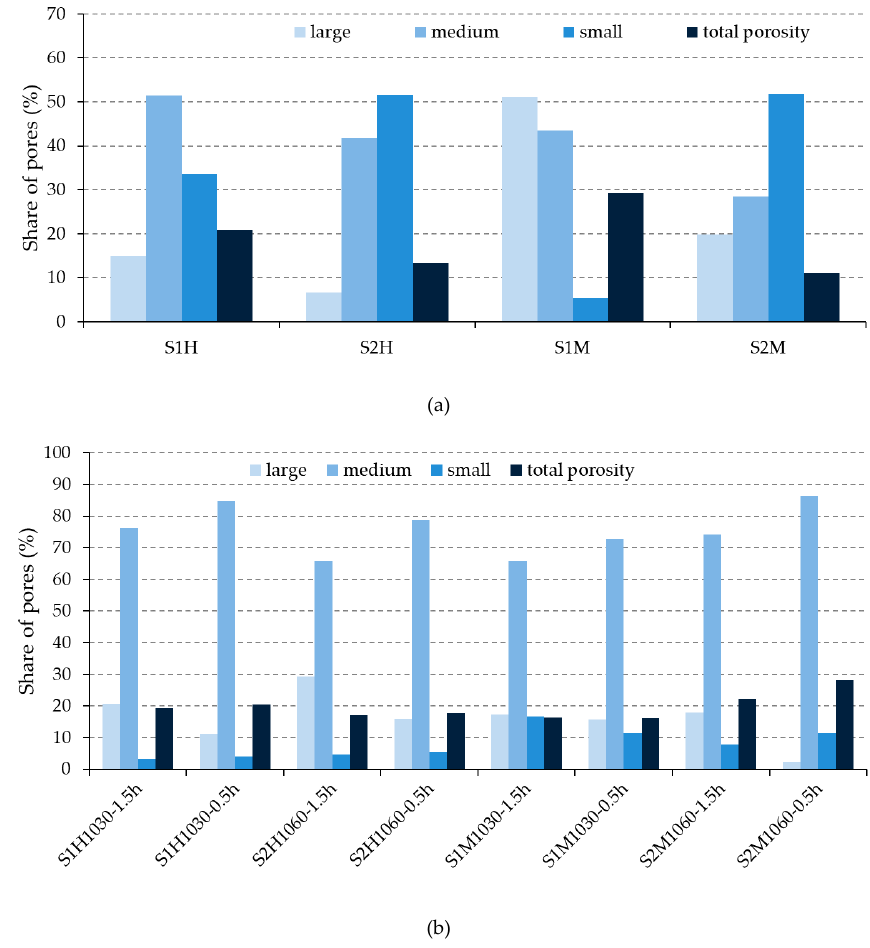
Figure 7. Pore-size distribution and total porosity of the ( a ) unfired bricks and ( b ) fired bricks. The appearance of the bricks after the exposure to freeze–thaw cycles are shown in Figure 8.